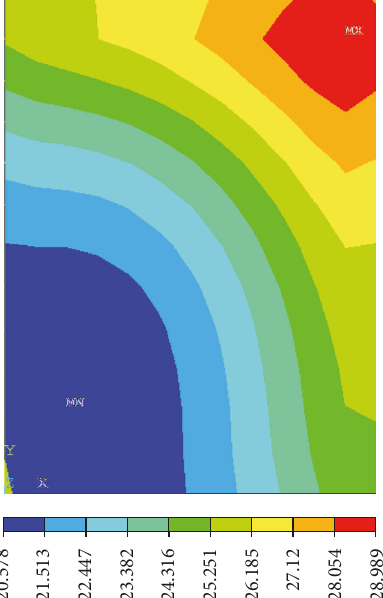
Figure 9: The temperature cloud chart at 2:00 pm.